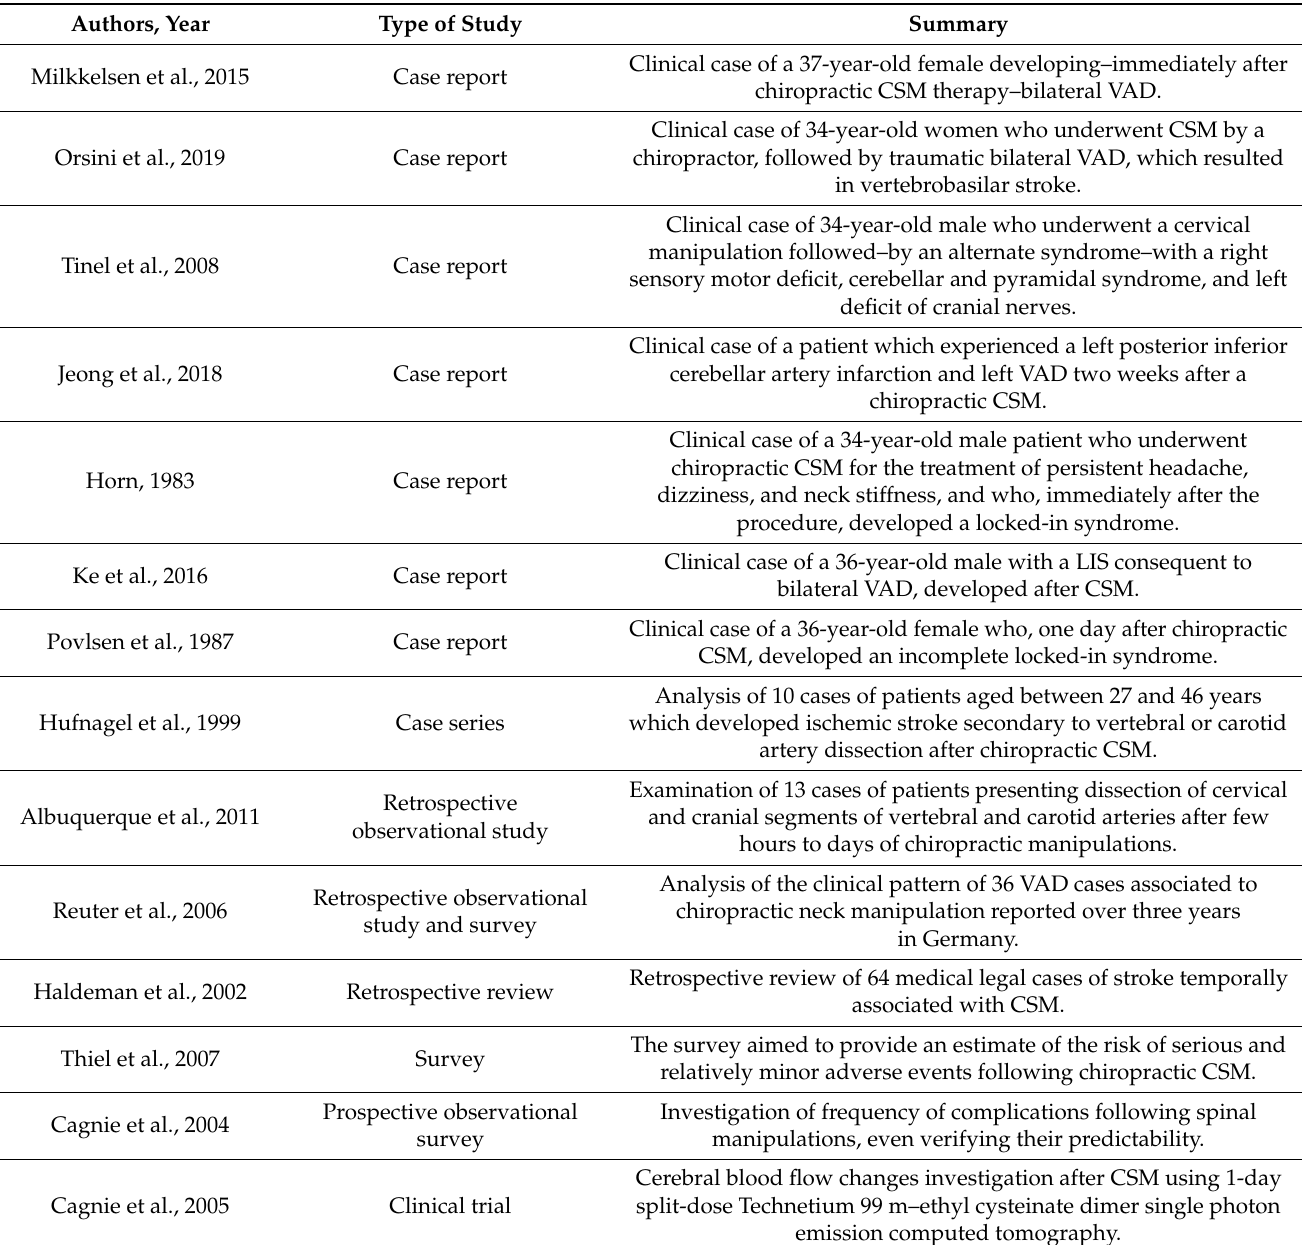
Table 1. Characteristics and summary of the analysed